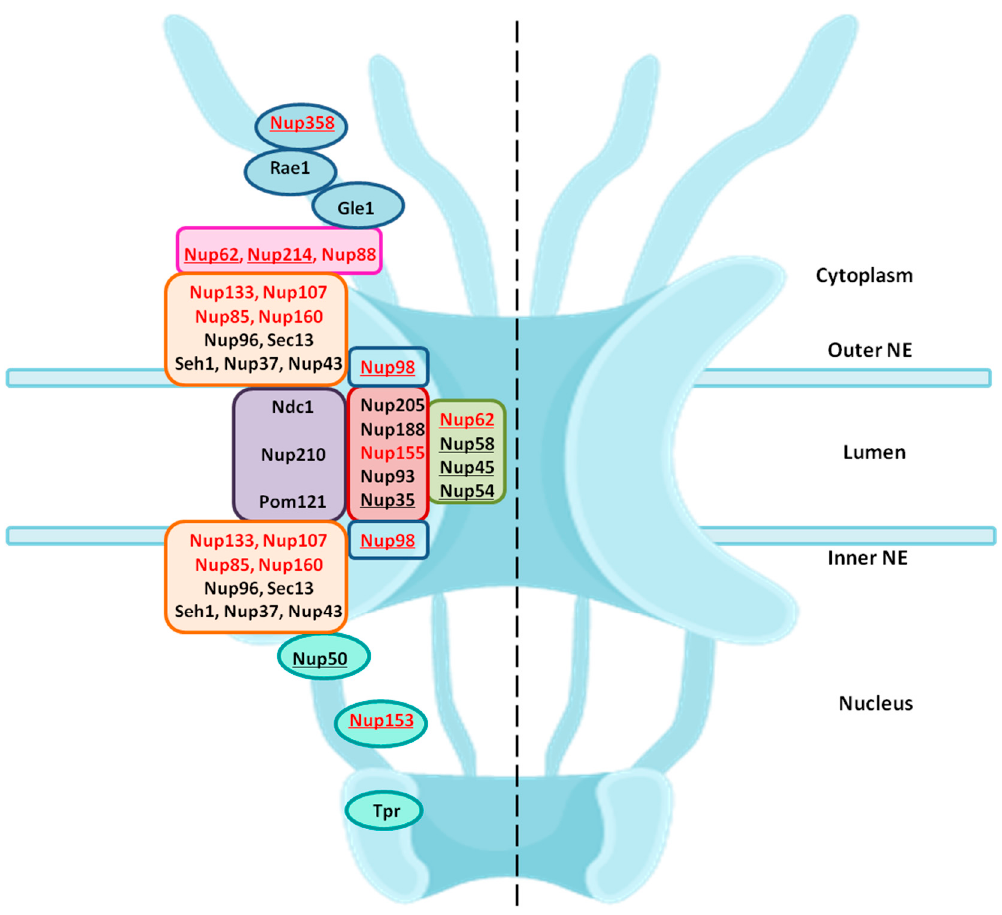
Figure 3. Structural organisation of nucleoporins in the NPC: Nups are organised into various subcomplexes, which here are shown in different coloured boxes. The location of Nups is marked on the left half of the NPC framework—the central transport channel / Nup62 subcomplex is shown in green; adapter ring / inner ring complex is in brick red; transmembrane Nups are in purple; Y-complexes are shown in orange; cytoplasmic ring Nups are in pink; Nups forming the cytoplasmic filaments are in light blue; nuclear basket is shown in teal color. The Nups highlighted in red are the ones identified as essential during the HIV-1 infection. The FG-Nups are